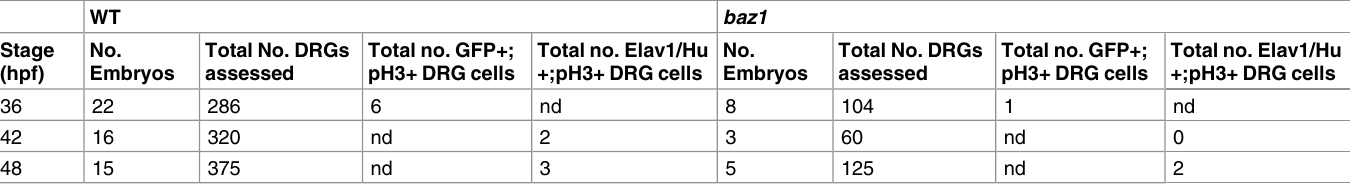
Table shows number of embryos scored, number of DRGs assessed per embryo and total number of pH3+ DRG cells in all embryos scored. nd, not